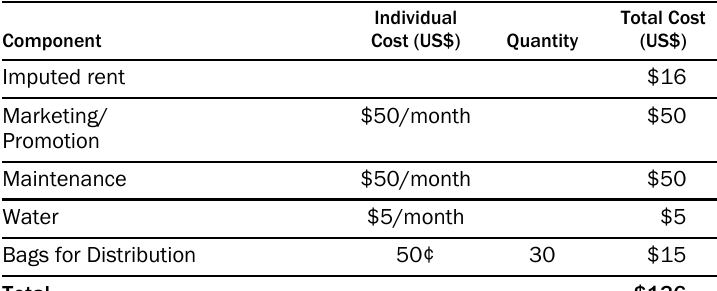
Table B2. Variable Costs of an Existing